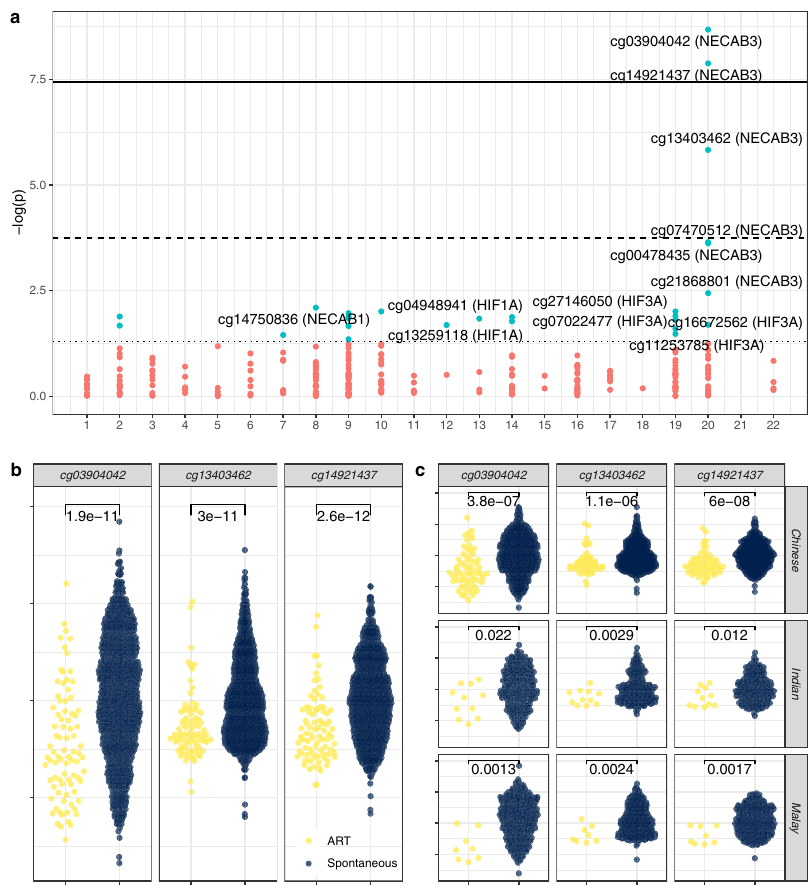
Fig. 4 Associations between ART status and fetal cord tissue DNA methylation. Associations between ART status and 281 candidate CpGs ( a ), three top NECAB3 CpGs ( b ), and three top NECAB3 CpGs strati fi ed by ethnicity ( c ), were estimated by multivariable linear regression adjusted for maternal ethnicity, age, parity, and pre-pregnancy BMI, and child sex. Horizontal thresholds represent P = 0.05; P = 1.8 × 10 -4 (Bonferroni correction); P = 3.6 × 10 − 8 (EWAS- threshold per Saffari et al. 2018 31 ). CpGs are grouped by chromosome with colors indicating P < 0.05. b , c show distributions of standardized methylation values with two-sided t test P values indicated. Sample sizes for all plots = 1094 spontaneous (598 Chinese, 205 Indian, 291 Malay); 83 ART (64 Chinese, 11 Indian, 8